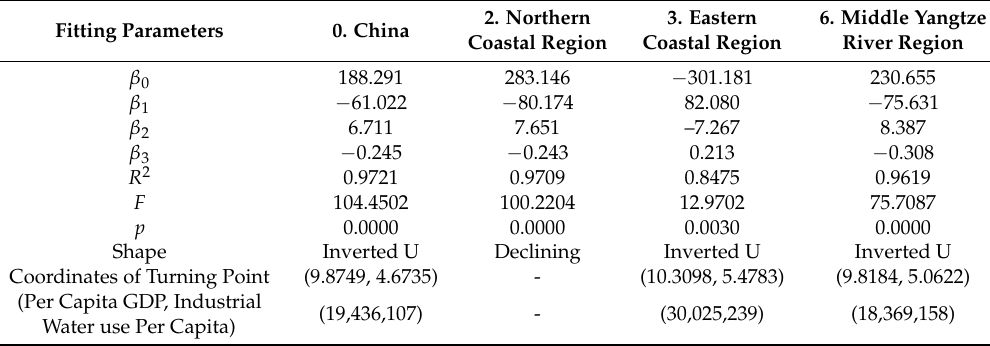
Table 5. Fitting parameters and analysis results corrected with the EKC